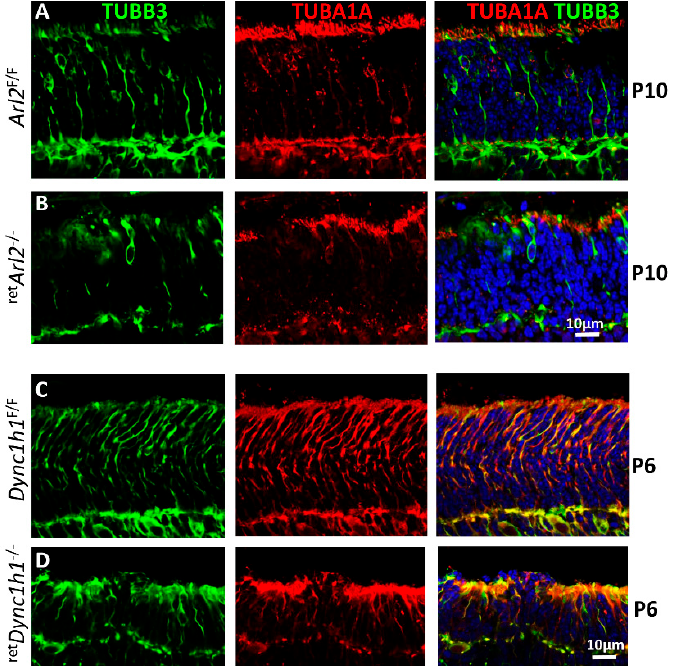
Figure 7. Retina-specific deletion of Arl2 and DYNC1H1 damages the MTC. ( A – D ), P10 Arl2 F/F (row ( A )), ret Arl2 − / − (row ( B )), P6 Dync1H1 F/F (row ( C )) and ret Dync1h1 − / − cryosections (row ( D )) probed with anti-TUBB3 (green) (( A – D ), left and right columns) and anti-TUBA1A antibodies (red) (middle and right columns). Note reduction in microtubules in knockout sections ( B , D ).